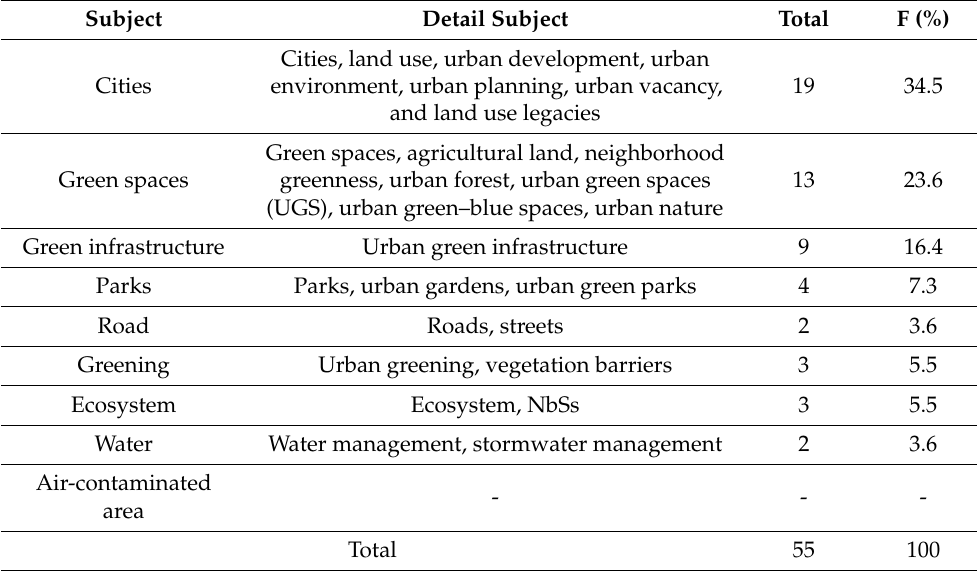
Table 7. International green infrastructure research